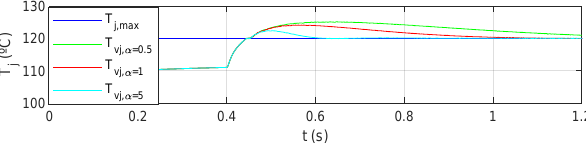
Figure 7. Thermal regulation dynamics vs. TCT parameter α .